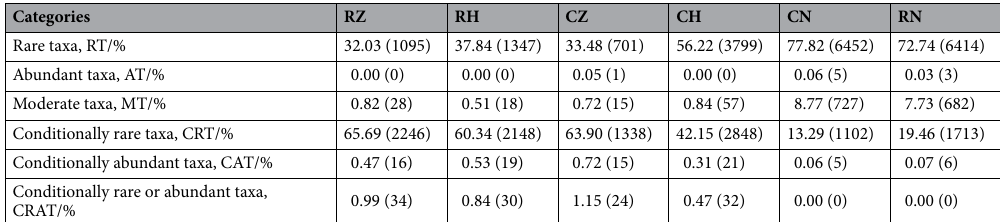
Table 1. Categories of bacterial taxa. The number of OTUs were showed in the